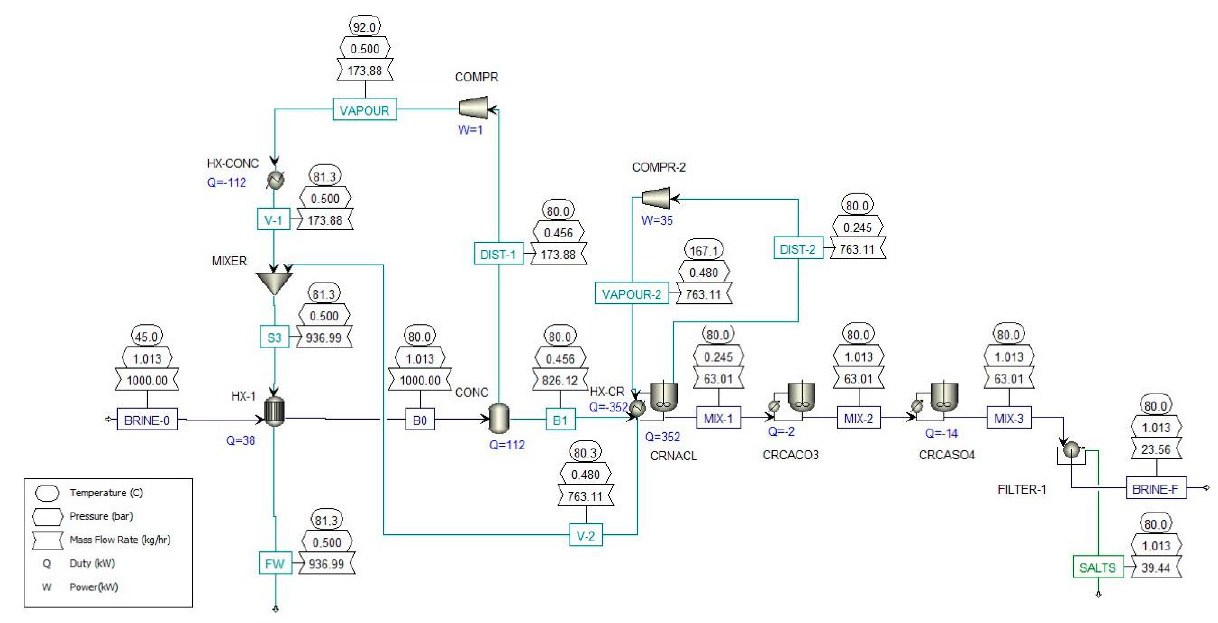
Figure 6. Flowsheet of simulation of the concentrator–crystallizer system on Aspen Plus for a scale of 1000 kg/h of feed brine.